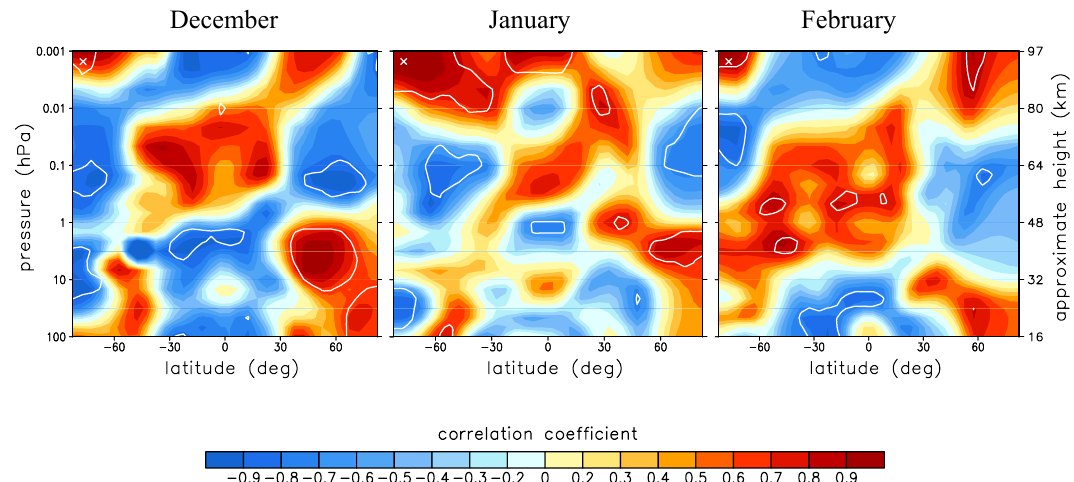
Fig.10 Fig. 10. Correlation coefficient for monthly averaged zonal mean temperature at each latitude/pressure with respect to that at the Antarctic summer mesopause region (0.005–0.001hPa, 60–85 ◦ S, approximate position marked with a “ × ”) for December (left side), January (mid- dle), and February (right side), respectively. The correlation is based on the year-to-year variability of monthly mean over the 5 winters (2004/2005–2008/2009). The white lines indicate the 90% level of